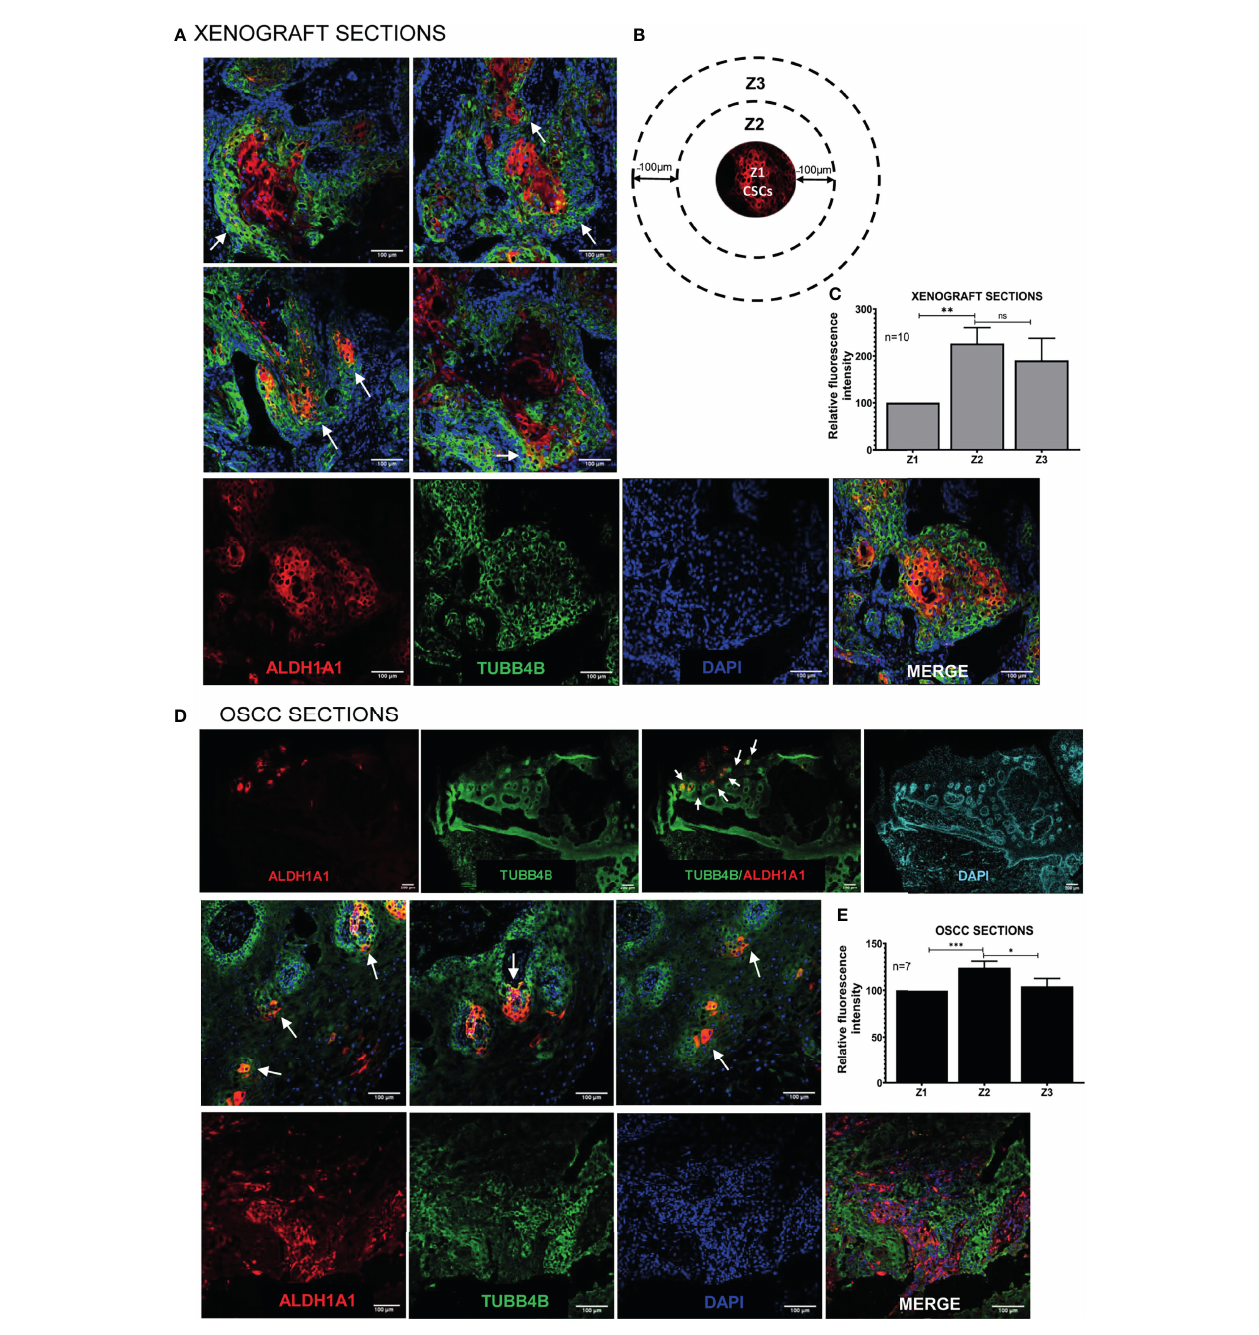
FIGURE 3 | TUBB4B is present in the CSC niche of Oral Cancer. (A) HSC3 xenograft sections were immunostained with antibodies against ALDH1A1 and TUBB4B, and confocal images were acquired. The region in and around ALDH1A1 + was arbitrarily divided into three zones, with Z1 representing the ALDH1A1 + stem cell population, Z2 representing the cells immediately surrounding 100 m m from Z1, and the region 100 m m further away from Z2 were considered as zone 3, schematically represented in (B) . Ten sections were stained and, three frames were captured from each section. Fluorescence intensities were measured by drawing ROIs in each zones and normalized intensity values were represented graphically (C) . The experiment was repeated with seven OSCC sections. (D) shows full fi eld stitched images and 20X images. The normalized fl uorescence intensity values were plotted (E) . Scale bar represents 100 m m for all 20X images and 200 m m for stitched images. Arrows point towards regions of increased TUBB4B expression in CSC niche. ns represents non-signi fi cant data, * represents p < 0.05, ** represents p < 0.01, *** represents p <